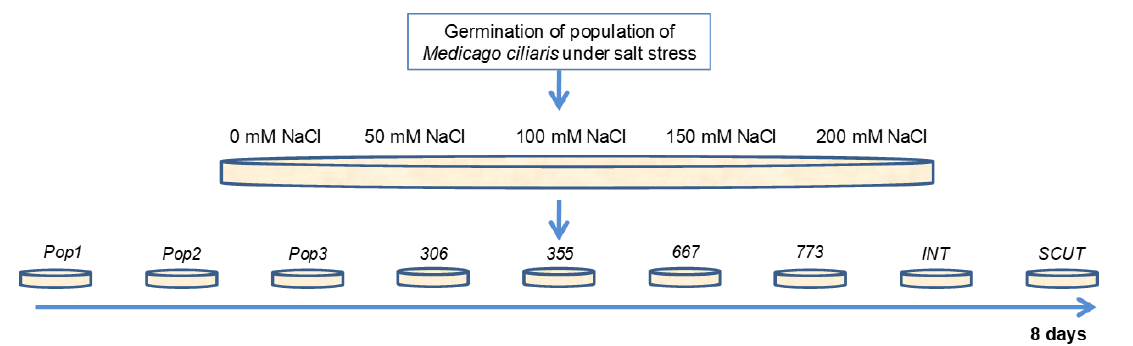
Figure 10. Protocol for germination test of seven populations of M. ciliaris ( Pop1, Pop2, Pop3, 306, 355, 667, 773 ), compared to one population of M. intertexta ( M. int ) and one population of M. scutellata ( M. scut ) under salt stress (0, 50, 100, 150, 200 mM NaCl equivalent to 5.9, 11, 16.5, 20 mMohs/cm at Temperature 25 °C).